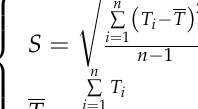
Figure 10. Temperature and its gradient fields in SiC crystal. ( a ) temperature for axisymmetric coil; ( b ) temperature for spiral coil; ( c ) temperature gradient for axisymmetric coil; ( d ) temperature gradient for spiral coil.